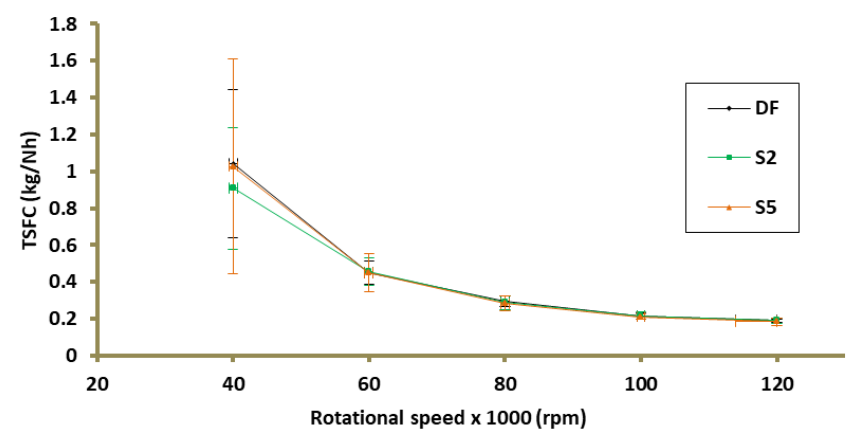
Figure 5. Thrust-specific fuel consumptions as a function of rotational speed.